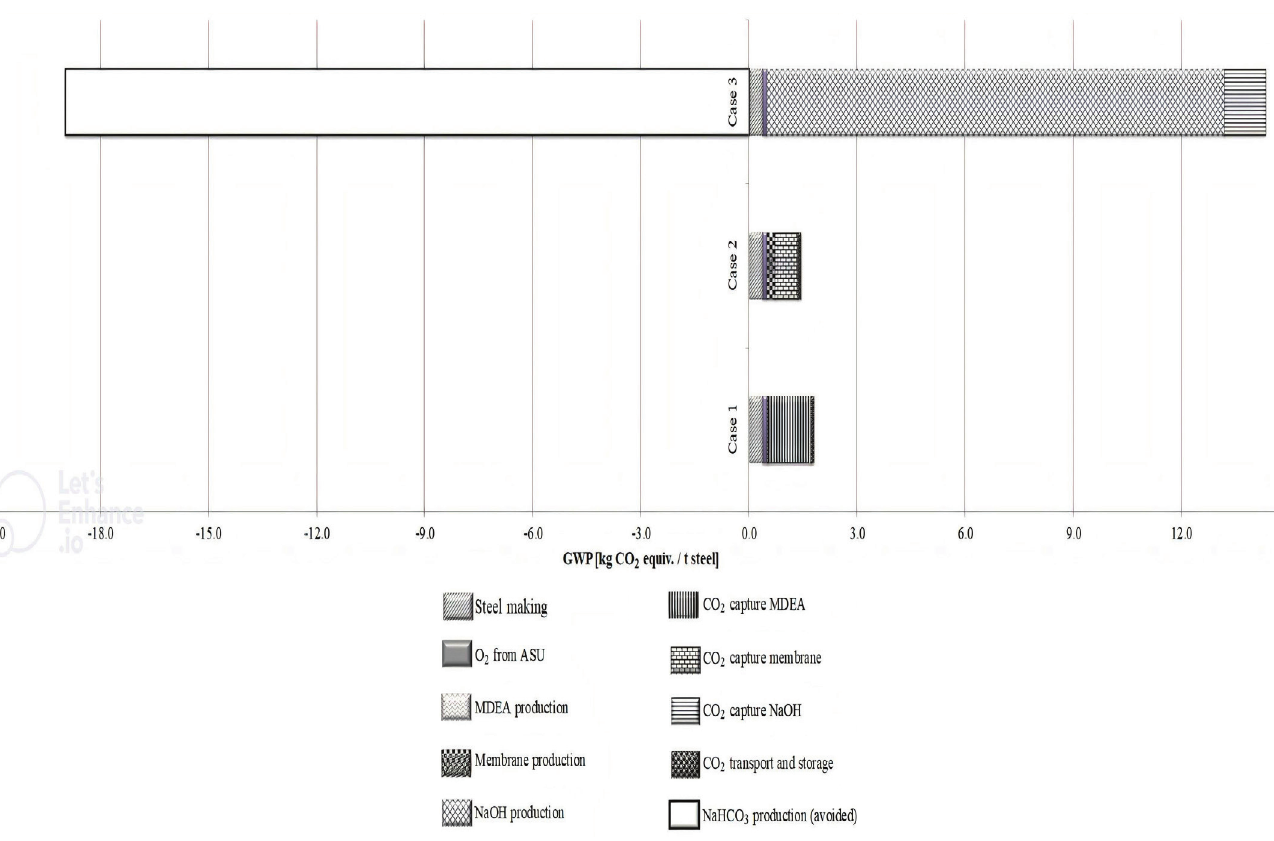
Units of measure Case 1* Case 2* Case 3